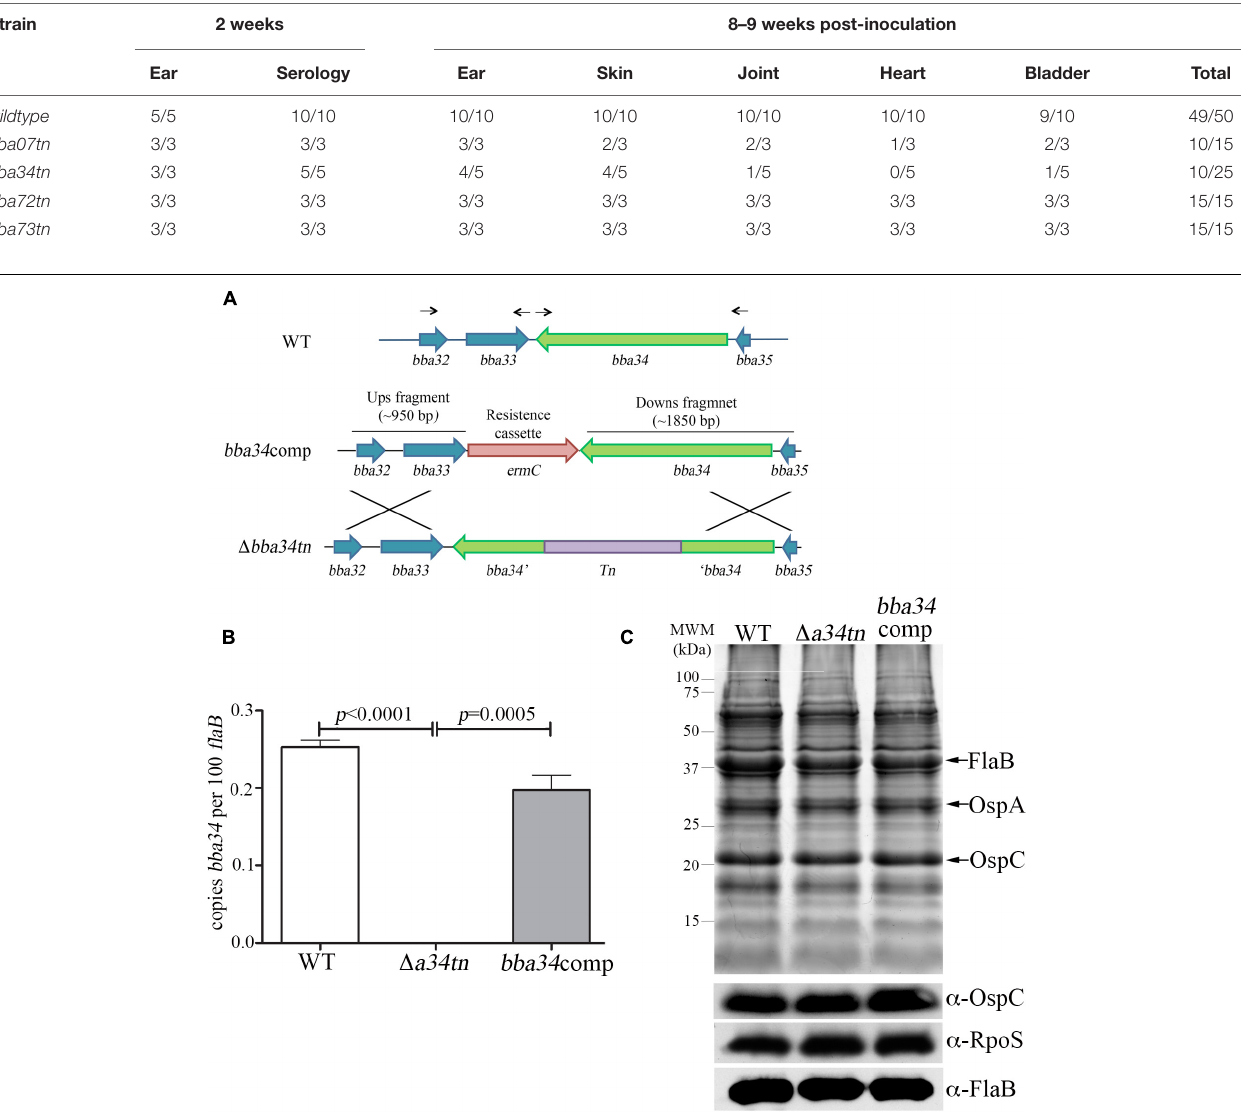
TABLE 4 | Tn mutant screen to identify RpoS-upregulated genes required for persistence in mice. Strain 2 weeks 8–9 weeks post-inoculation